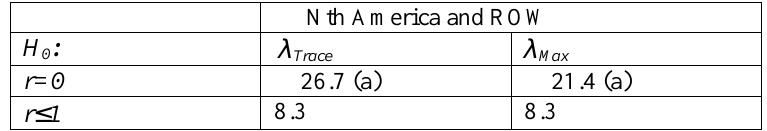
Table 1: Johansen Rank Tests